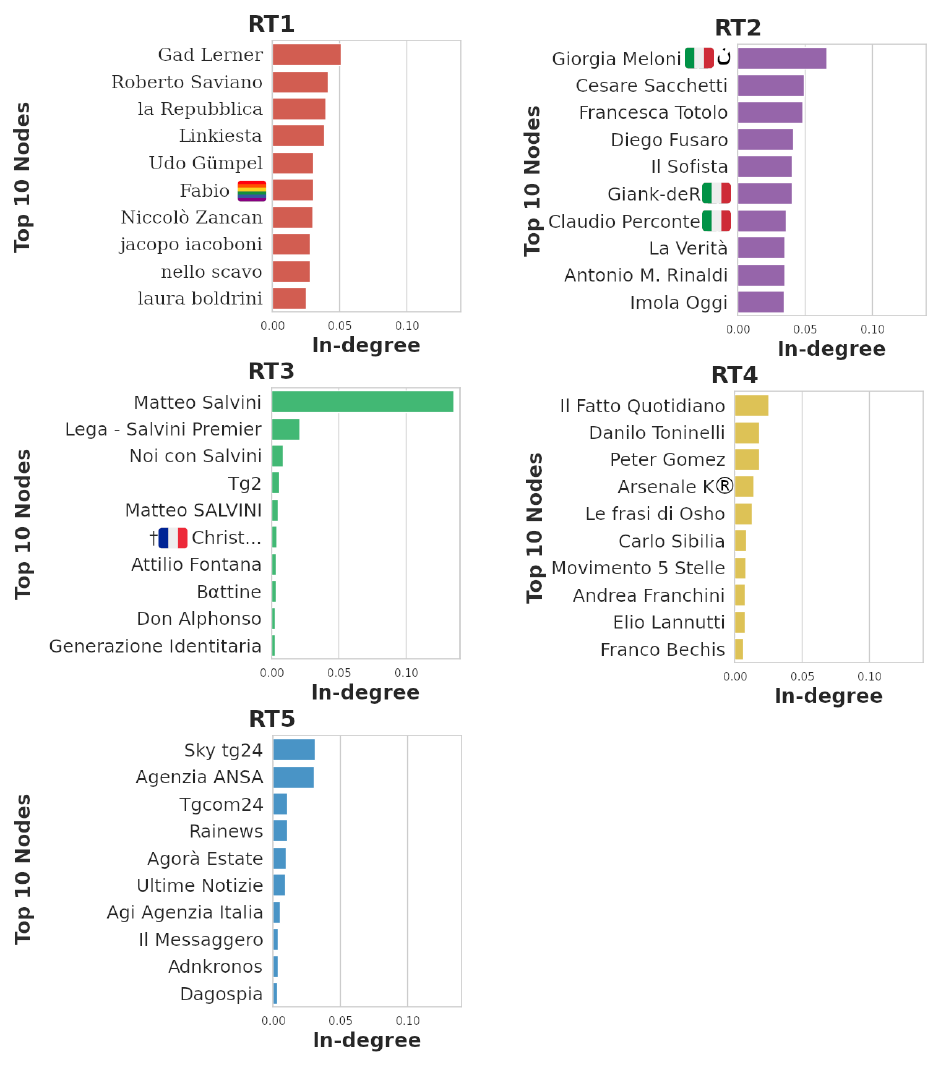
Figure 5. In-degree distribution of the top 10 nodes in each community. The degree centrality values are normalised by dividing by the maximum possible degree. We can see how a relatively smaller community, like RT3, sets the scale for all the others thanks to the presence of Matteo Salvini, one of the most active Italian politicians on social